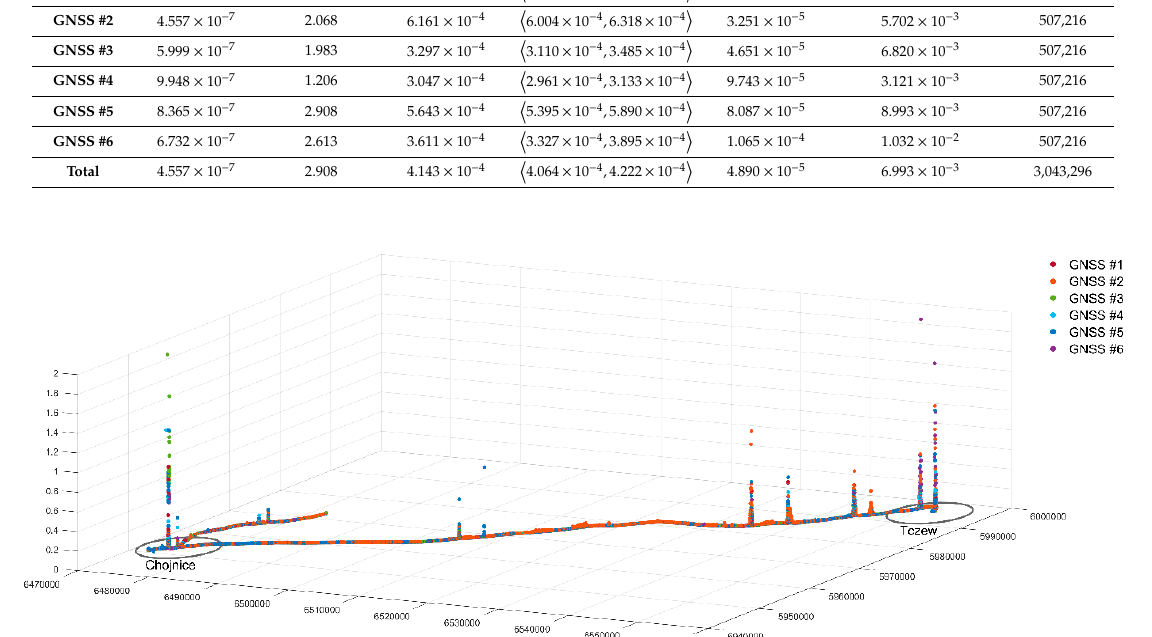
Table 5. Results of statistical analyses of the error of determining the antenna position coordinates following the alignment.